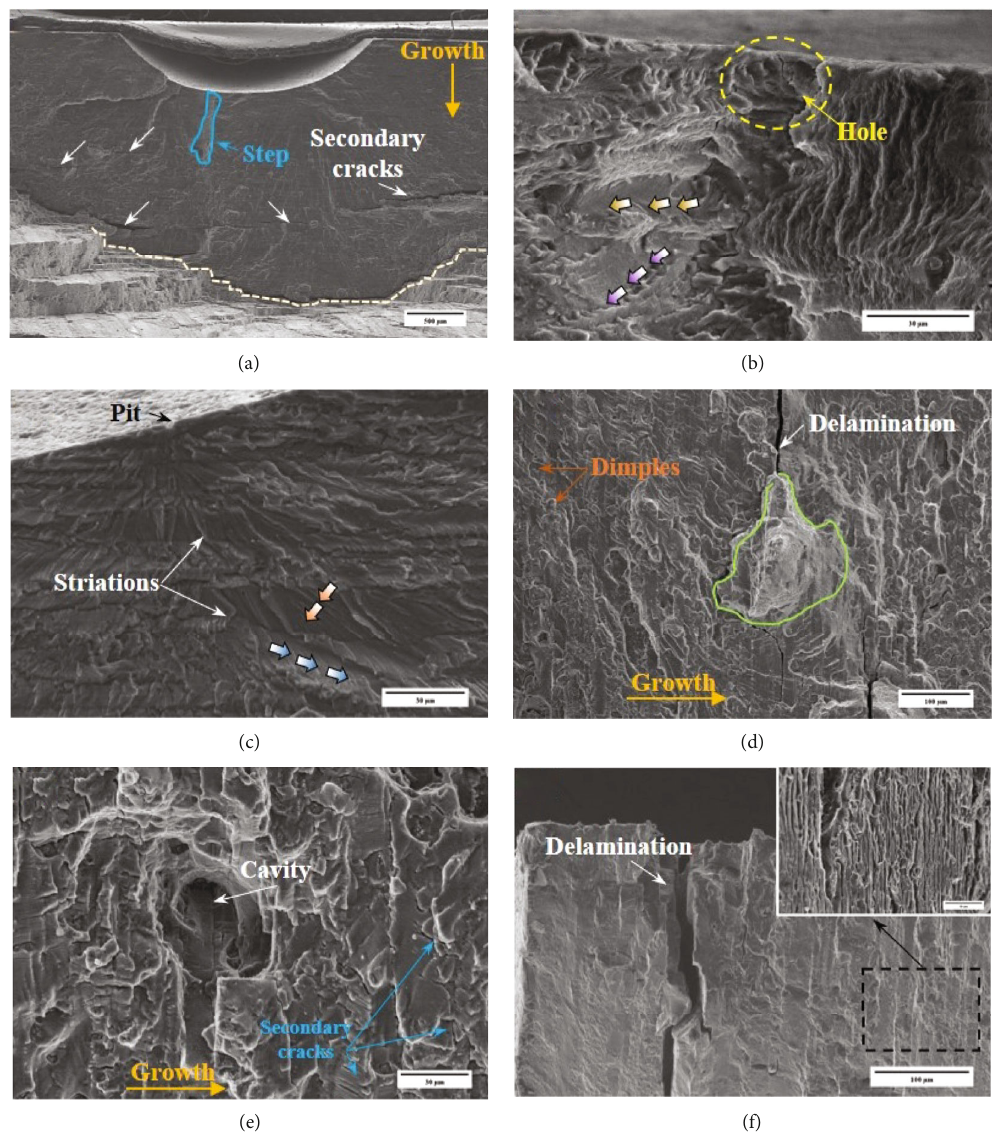
Figure 13: SEM images of the fracture surface: (a) overall view; (b, c) fatigue crack source zone; (d, e) typical features in fatigue crack propagation region; (f) fi nal fracture